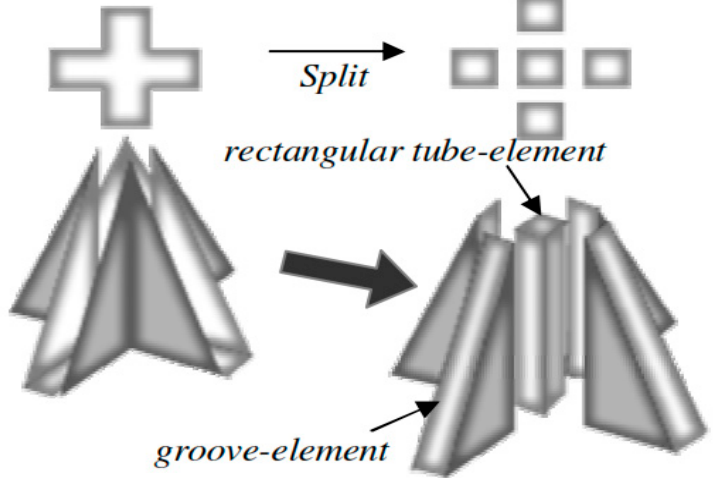
Figure 4. Two different capillary phenomena used in modelling of crown shaped MNs (adopted from [80]).